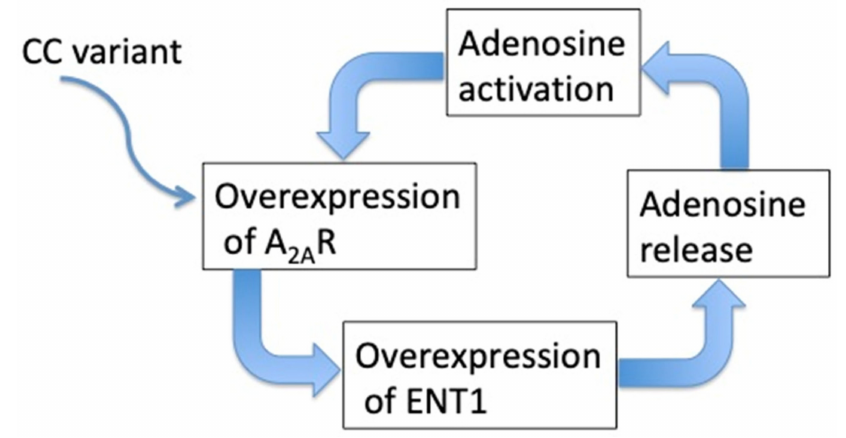
Figure 3. the vicious circle of adenosine release in vasovagal